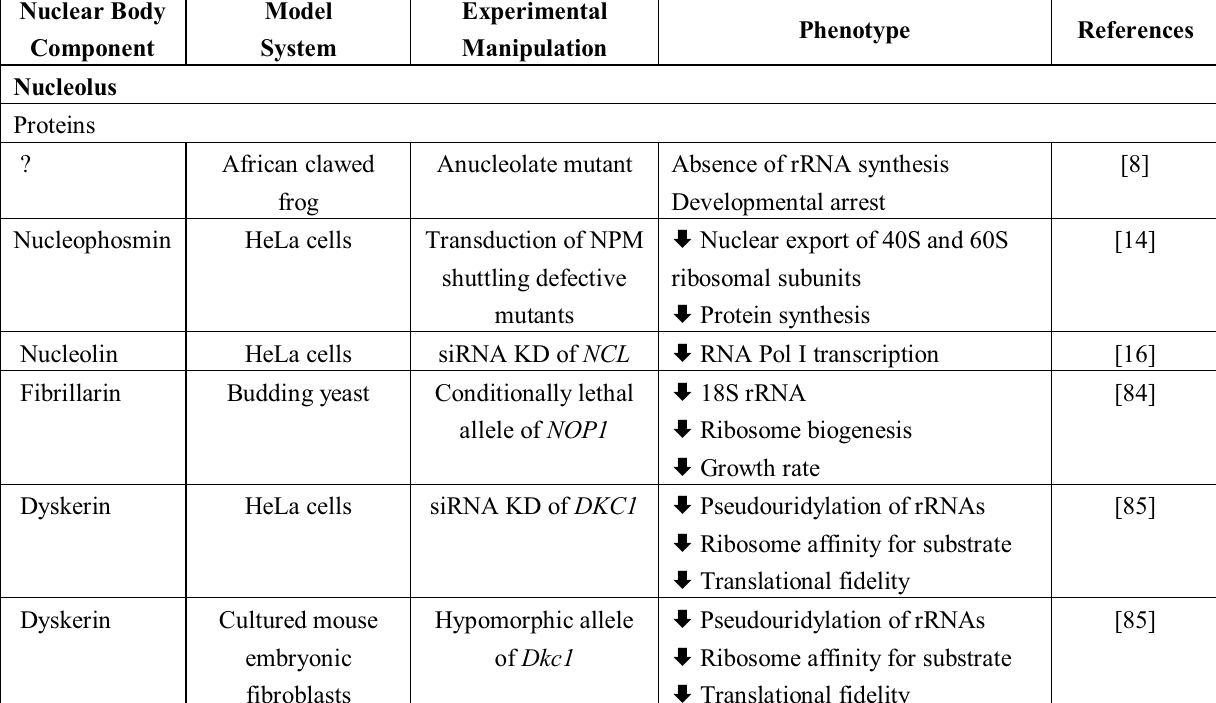
Table 2. Selected examples of model systems deficient for nuclear body